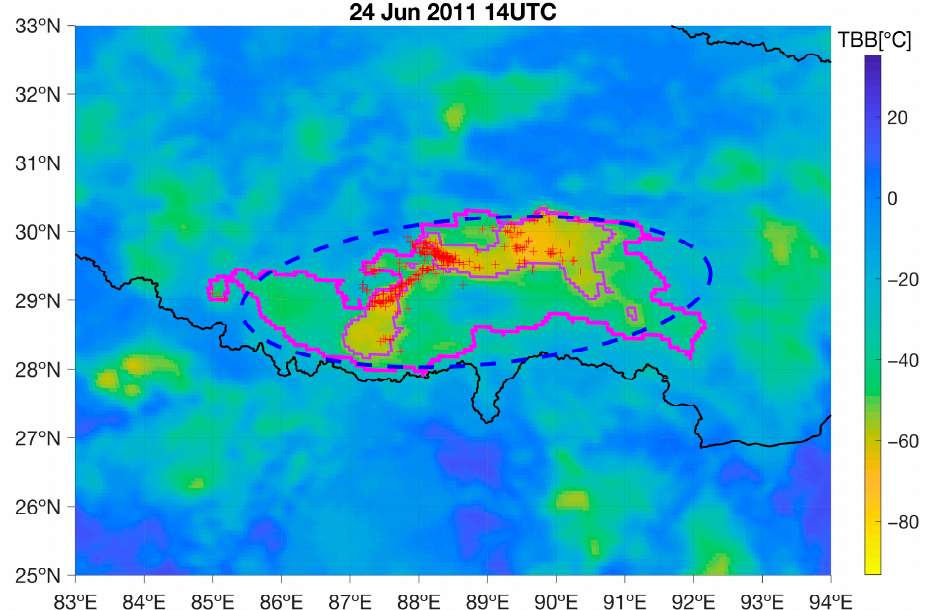
Figure 1. An example of the identified thunderstorm cloud on 24 June 2011. The pink lines delineate the region with TBB ≤ − 32 °C. The purple lines enclose the region with TBB ≤ − 52 °C. The blue dashed line indicates an ellipse fitting the region with TBB ≤ − 32 °C. Red “+” signs mark the location of the WWLLN lightning. The blue “ ” marks the position of the centroid of the thunderstorm cloud.